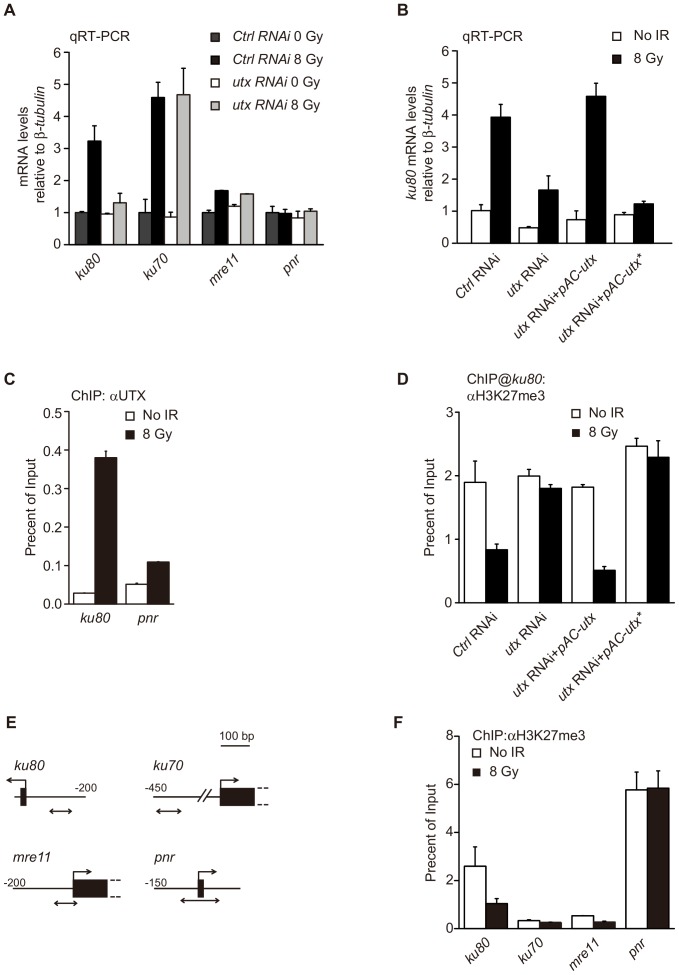
UTX is required for the expression of ku80 after IR exposure via the demethylation of H3K27me3 in Kc cells.(A) qRT-PCR analysis of the mRNA expression of the indicated genes before and after IR exposure in RNAi-treated Kc cells. The relative expression levels are normalized to β-tubulin levels. Note that ku80 is the only gene that requires utx for its expression. (B) qRT-PCT analysis of ku80 expression in different treatment cell. Over-expression WT UTX could rescue ku80 expression in UTX RNAi cell after IR but not mutant UTX. (C) ChIP assay with an anti-UTX antibody and the ku80 promoter with and without IR. Note the dramatic increase in the UTX occupancy of the ku80 promoter after IR. (D) ChIP assay for H3K27me3 at the ku80 promoter in different treatment Kc cells after IR. (E) The diagrams show PCR-amplified regions (double arrows) relative to the first exons (black box) in the ChIP analysis of the three DNA repair genes ku80, ku70 and mre11 and a control gene, panier (pnr). (F) Changes in H3K27me3 levels at the indicated genes 2 hours after IR treatment with a dose of 8 Gy. The H3K27me3 levels in the promoter regions of those genes were determined via ChIP assays and compared to the input genomic DNA.